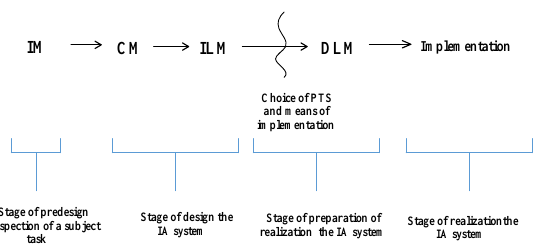
Fig.1 . Methodology of automation of intellectual work, where IM is the initial model, CM - conceptual model, ILM